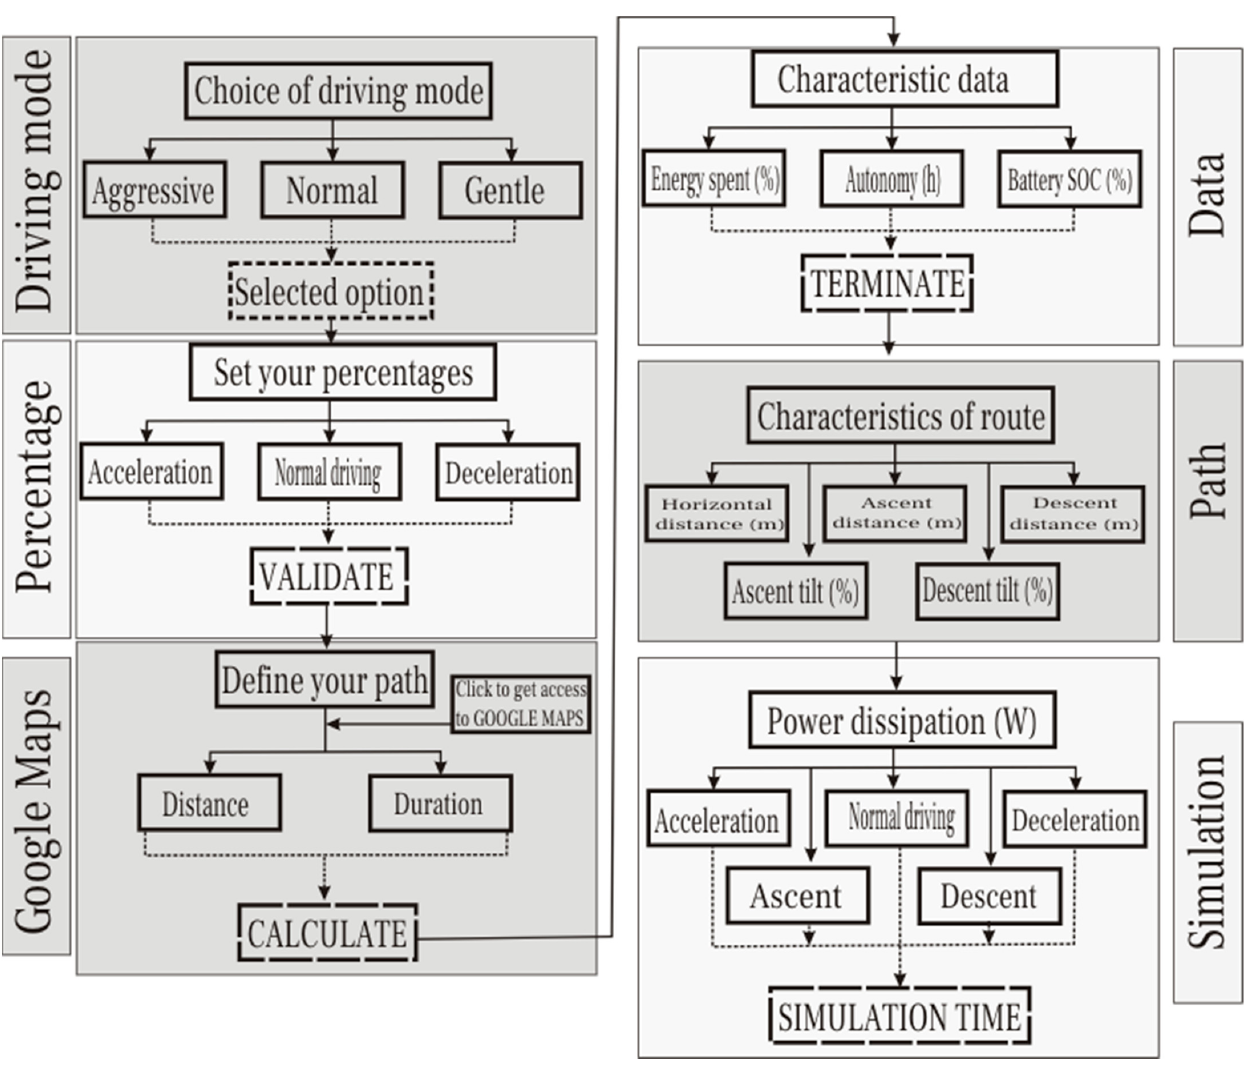
Figure 5. Block diagram of simulation process.